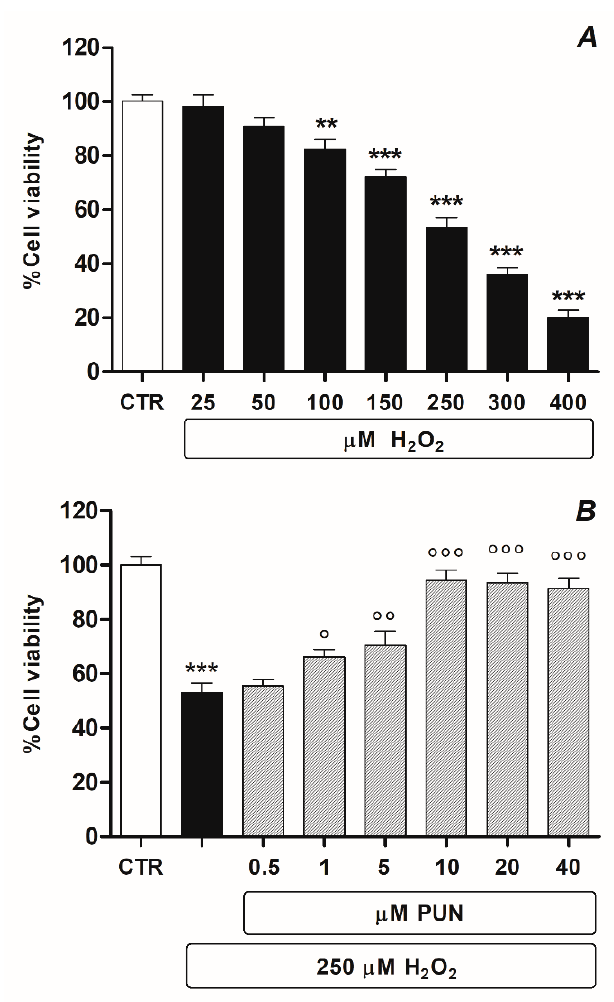
Figure 1. Viability of ARPE–19 cells treated with H 2 O 2 (range 25–400 µ M) for 24 h ( A ) and protective effect of 24 h pre–treatment with multidose PUN (range 0.5–40 µ M) ( B ). Data from two independent experiments are expressed as percentage viability values with respect to untreated cells (control = 100%) and are presented as the mean ± SEM of six replicates per experimental group. One– way ANOVA analysis was carried out followed by Dunnett’s or Newman–Keuls test for multiple comparisons with a control or for pairwise comparisons among sample means. Note: ** = p < 0.01 and *** = p < 0.001 vs. untreated control; ◦ = p < 0.05, ◦◦ = p < 0.01, ◦◦◦ = p < 0.001 vs. H 2 O 2